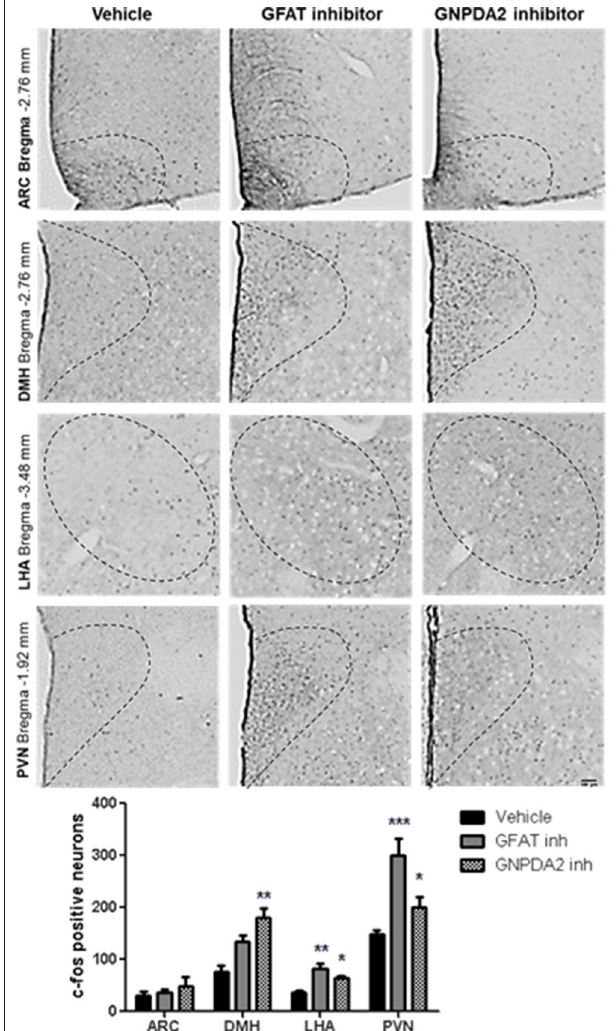
FIGURE 2 | Neuronal activation by central infusion of GNPDA2 and GFAT inhibitors. Analysis of c-Fos positive neurons in ARC, PVN, DMH and LHA. Representative images of each hypothalamic nuclei. One-way ANOVA analysis, Tukey’s post-hoc test. * P < 0.05, ** P < 0.01, *** P < 0.001. n = 8 rats per